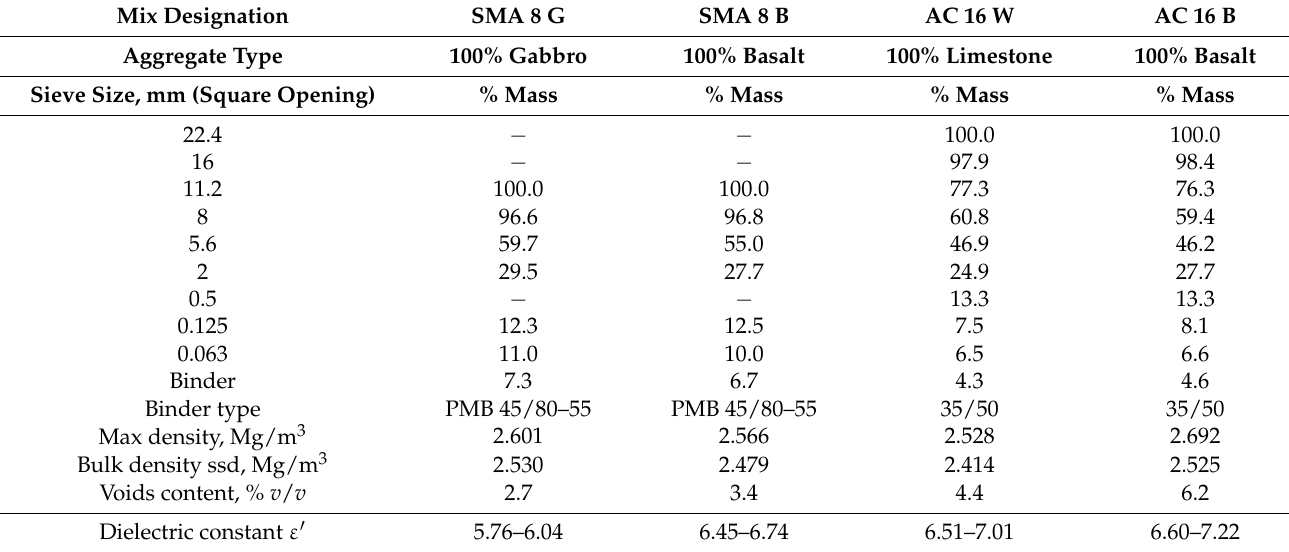
Table 3. Asphalt mix design used in the project.